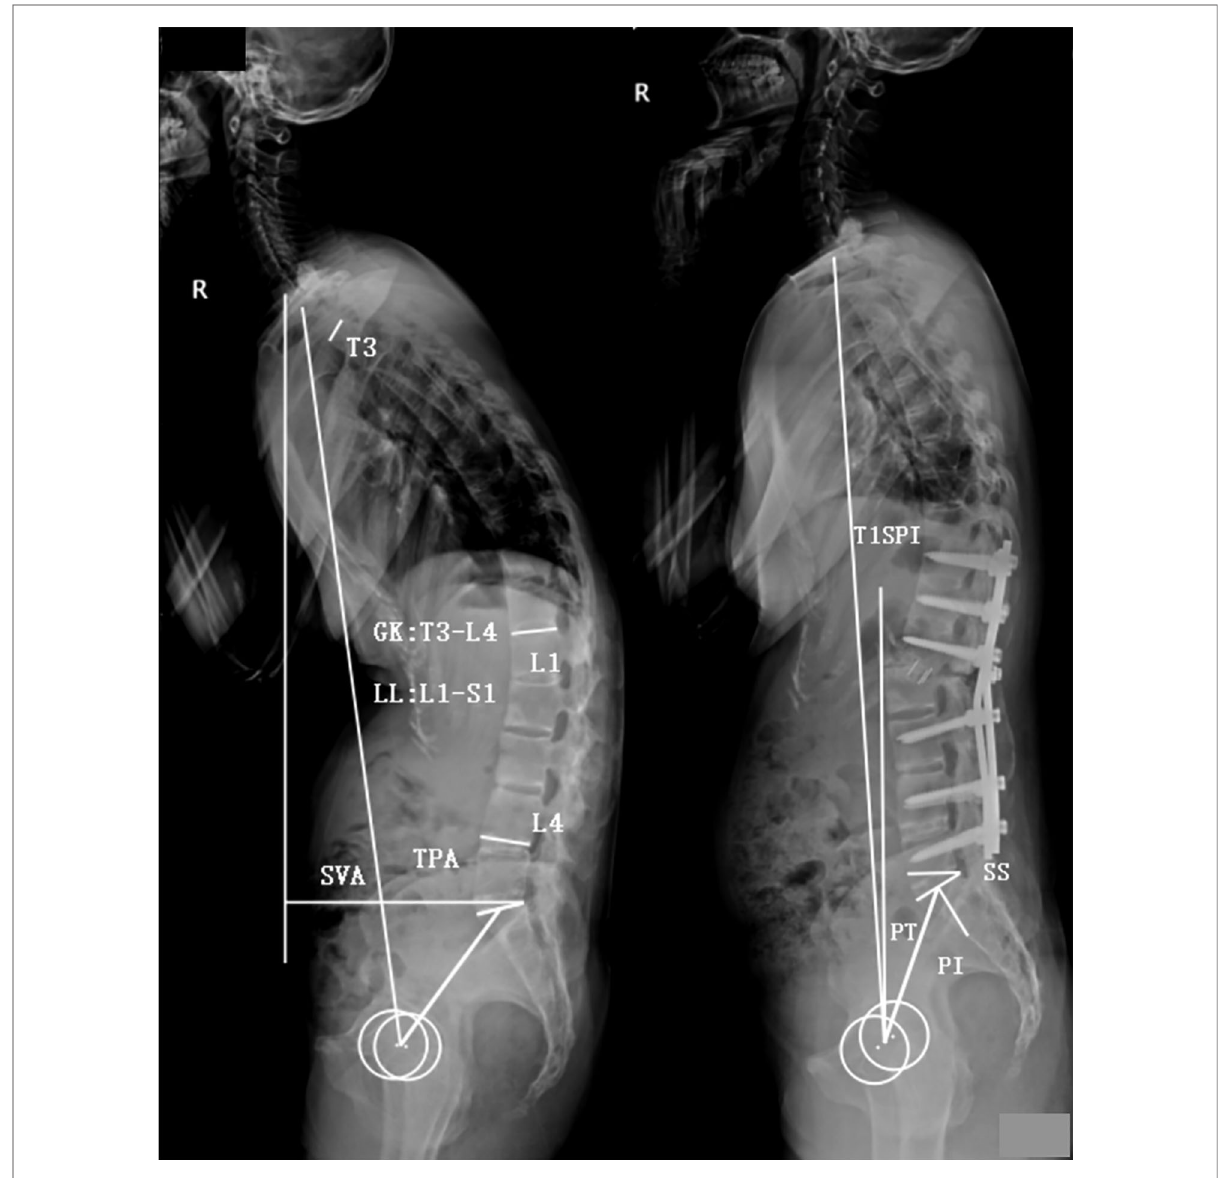
FIGURE 1 Illustration of radiographic parameters. Global kyphosis (GK): the angle between the superior endplate of the maximally tilted upper-end vertebra and the inferior endplate of the maximally tilted lower-end vertebra. Lumbar lordosis (LL): the Cobb angle from the L1 upper endplate to the S1 upper endplate (negative number represents lordosis, and positive number represents kyphosis). Sagittal vertical axis (SVA): the distance between the C7 plumb line and the posterior-superior corner of S1. T1 pelvic angle (TPA): the angle between a line joining the center of T1 and the femoral head axis and a line from the center of the femoral head axis to the midpoint of the S1 upper endplate. T1 spinopelvic inclination (T1SPI): the angle between the vertical line and a line from the center of the femoral head axis to the center of the T1 vertebral body (a negative number represents that T1 is posterior to the femoral head, and a positive number represents that T1 is anterior to the femoral head). Pelvic tilt (PT): the angle between the vertical line and the line from the center of the S1 upper endplate to the center of the femoral head axis. Pelvic incidence (PI): the angle between the perpendicular line to the S1 upper endplate and the line from the center of the S1 upper endplate to the center of the femoral head axis. Sacral slope (SS): the angle between the S1 upper endplate and the horizontal line. Pelvic incidence and lumbar lordosis mismatch (PI – LL): pelvic incidence value minus lumbar lordosis